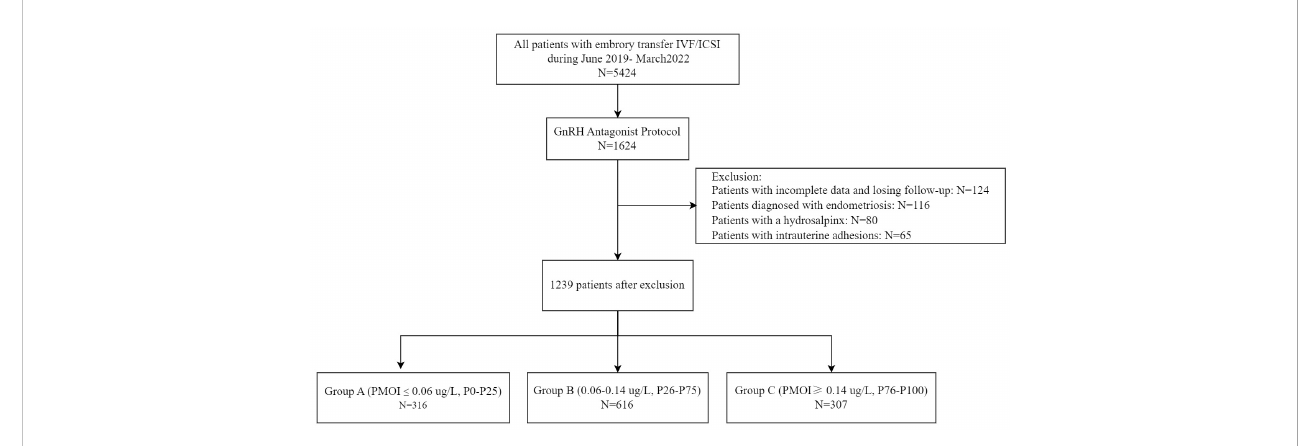
FIGURE 1 Flow chart of the